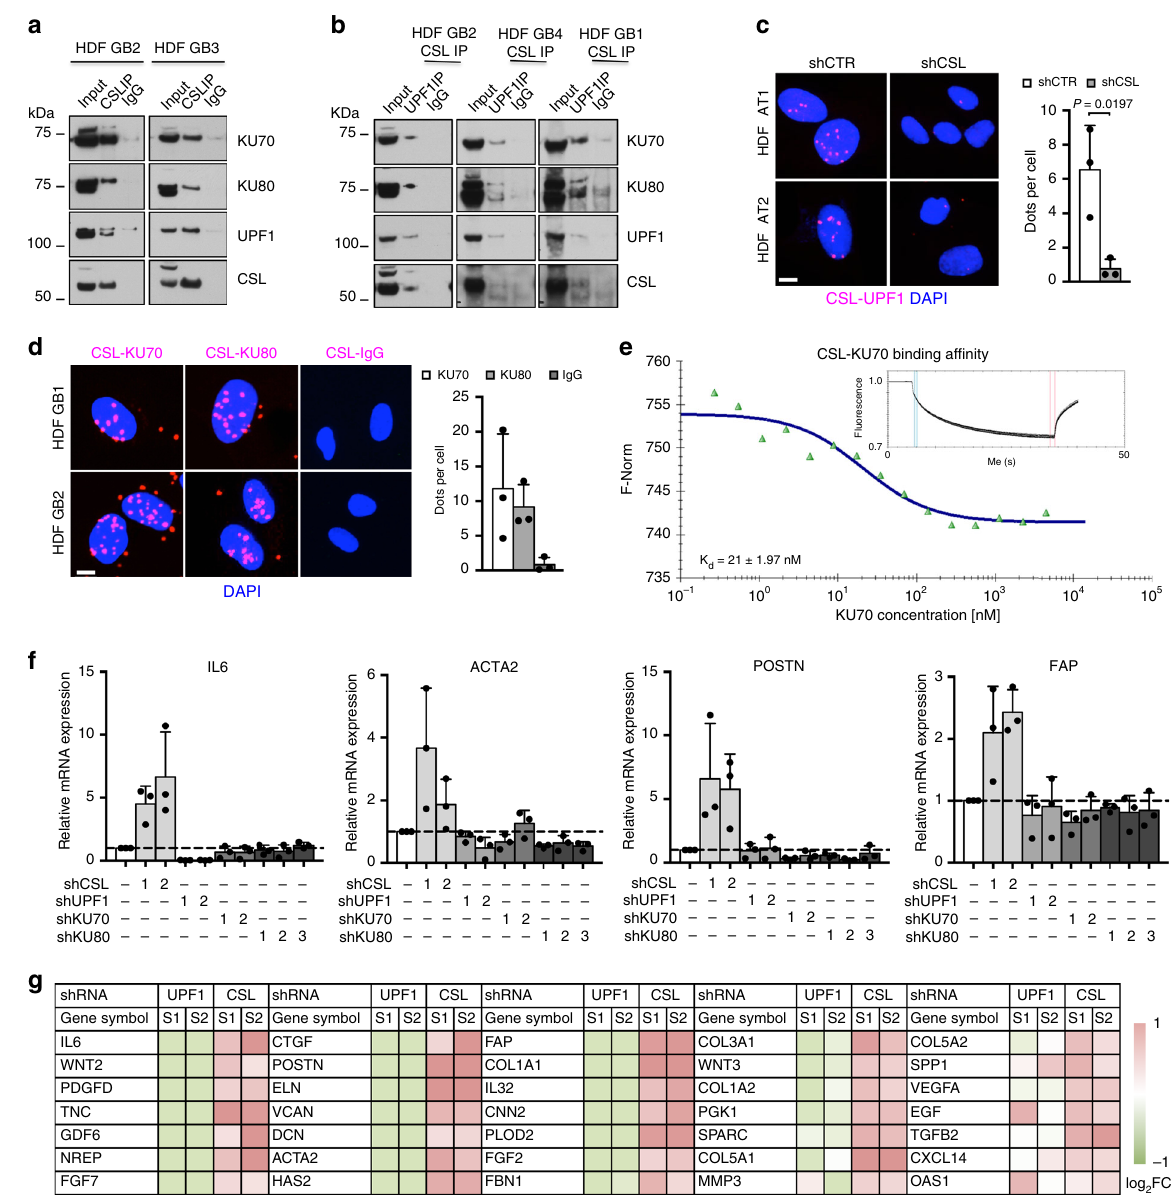
Fig. 5 CSL binds to Ku70, Ku80, and UPF1 forming a multiprotein complex. a Co-immunoprecipitation (co-IP) analysis of HDFs with anti-CSL antibodies or non-immune IgG followed by immunoblotting with antibodies against the indicated proteins. n (strain) = 2. b Sequential co-IP analysis of HDFs with antibodies against CSL followed by IP with antibodies against UPF1 or non-immune IgG, and immunoblotting with antibodies against the indicated proteins. n (strain) = 3. c Proximity ligation assays (PLAs) of CSL and UPF1 association. HDFs with silenced CSL were used as negative control. Scale bar, 2 μ m. Number of dots per cell was counted. n (cells) > 43 per condition, n (strain) = 3, * p < 0.05, two-tailed unpaired t -test. d PLAs of CSL and Ku70 and Ku80 association. Scale bar, 2 μ m. Number of dots per cell was counted. n (cells) > 54 per condition, n (strain) = 3. e Binding of recombinant CSL and Ku70 proteins as measured by microscale thermophoresis (MST). Inset: thermophoretic movement of fl uorescently-labeled CSL. Speci fi city controls are in Supplementary Fig. 5c, d. f RT-qPCR of CAF effector genes in HDFs plus/minus UPF1/Ku70/Ku80 versus CSL gene silencing for 6 days. Silencing controls are in Supplementary Fig. 6a. g RNA-seq analysis of CAF effector genes in HDFs plus/minus UPF1 versus CSL gene silencing for 7 days. Heatmap of differentially expressed genes in HDFs with CSL or UPF1 silencing relative to control is in log2 scale. Bars represent mean ±